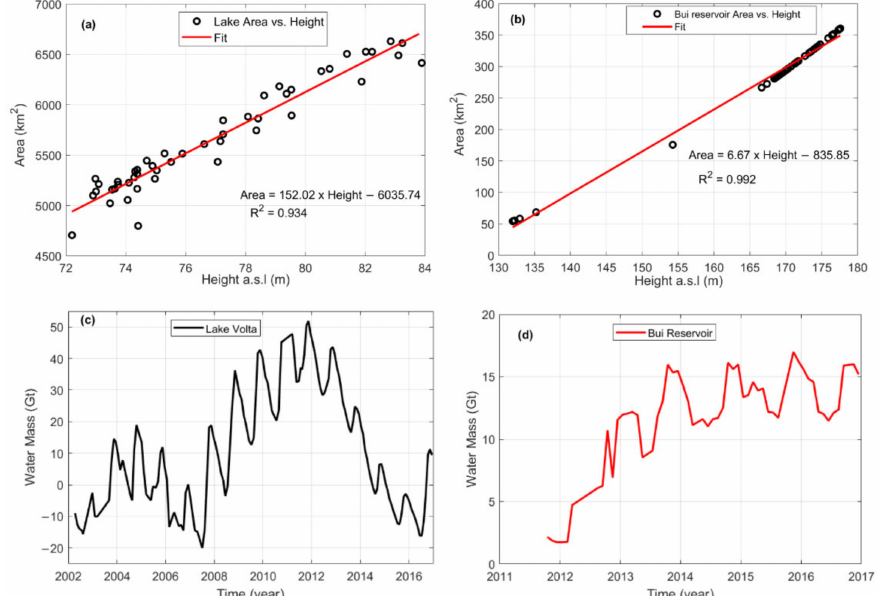
Figure 5. Regression models between radar altimetry-derived water level and imageries-derived water area changes: ( a ) for Lake Volta and ( b ) Bui Reservoir. Estimated surface water mass changes based on water area-height relationship for ( c ) Lake Volta and ( d ) Bui reservoir from 2002 to 2016 and 2011 to 2016,